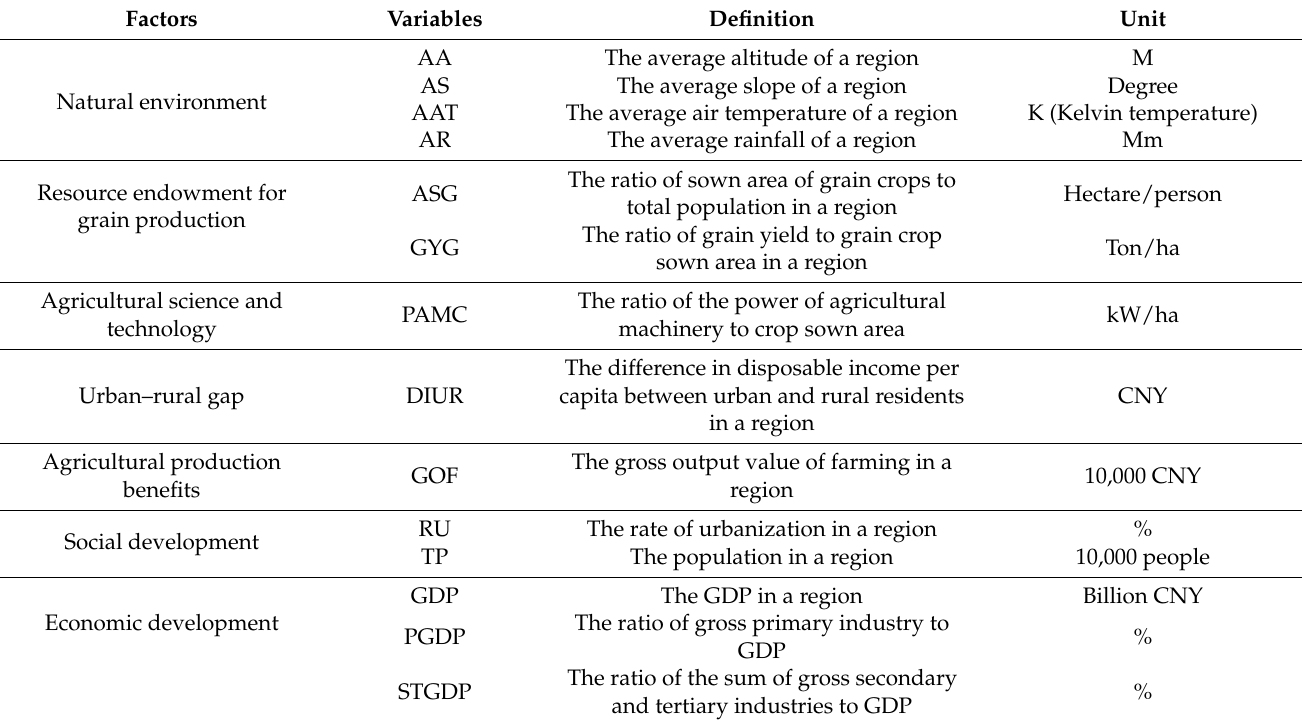
Table 1. Variables of non-grain